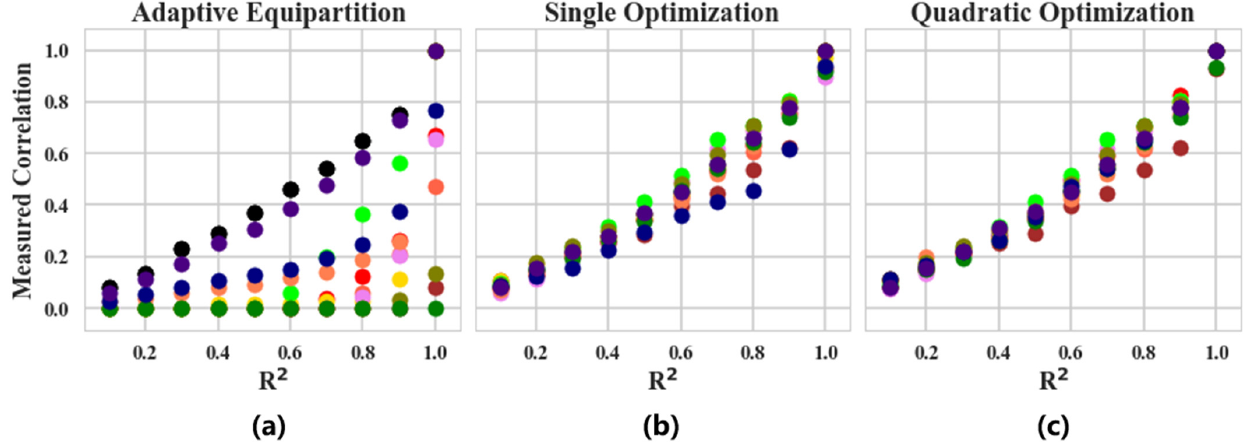
Figure 3. Comparison of equitability of adaptive equipartition, single optimization and quadratic optimization.